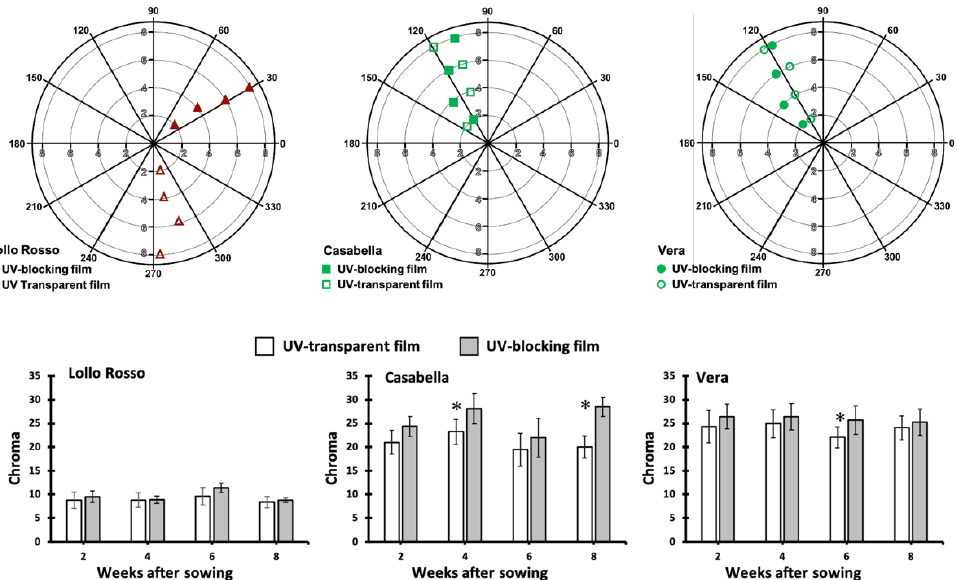
Figure 6. Hue angle vs. sampling week (polar plot) and chroma values vs. sampling week (bars chart) of three cultivars of lettuce. Vertical bars show SE ( n = 18). * indicates significant differences within each cultivar between UV-transparent and UV-blocking films according to LSD test at p < 0.05. No symbol indicates no differences.